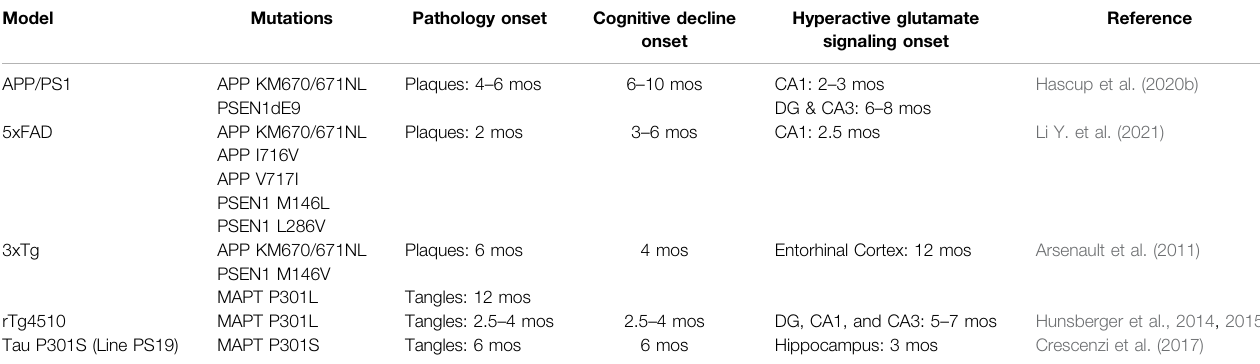
TABLE 1 | The onset of pathological, cognitive and glutamatergic changes in AD mouse models.